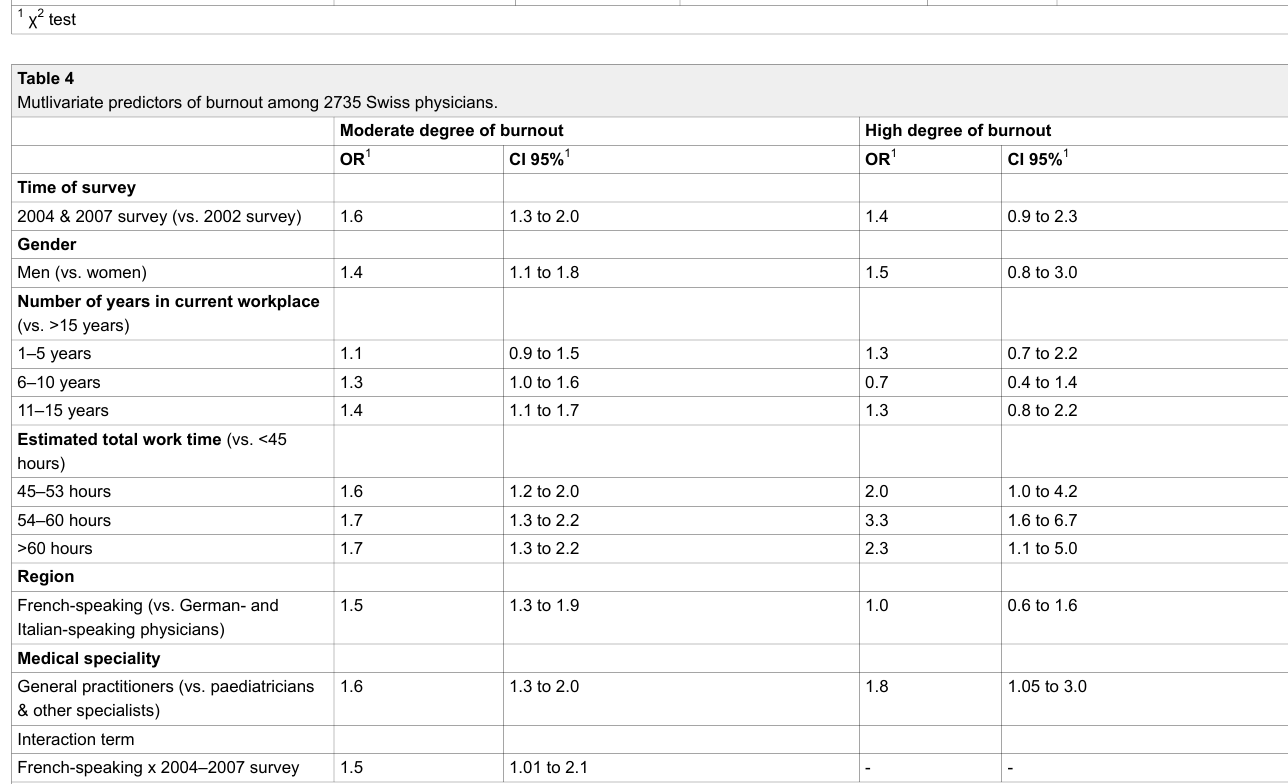
1 Odds ratio and 95% CI are adjusted for all other factors listed in the